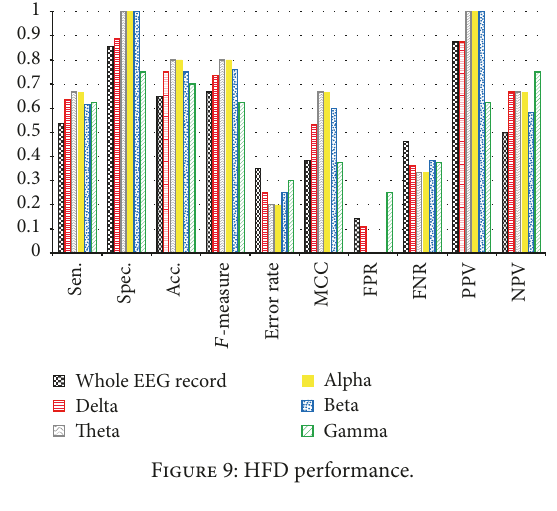
Figure 9: HFD performance.